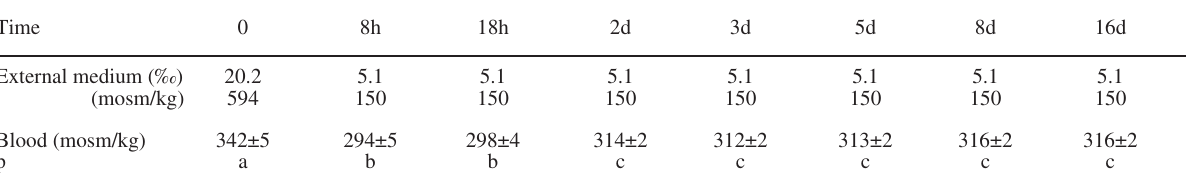
Table 1. – Changes in blood osmolality in Pomatoschistus microps after rapid transfer from an original medium (594 mosm/kg, 20.2) to a diluted medium (150 mosm/kg, 5.1) at 20°C (eXP1). data are given as mean ± se; n = 5 except at 5 days where n = 9; h = hours and d = days. letter of the last line: different letters indicate significant differences in blood osmolality.